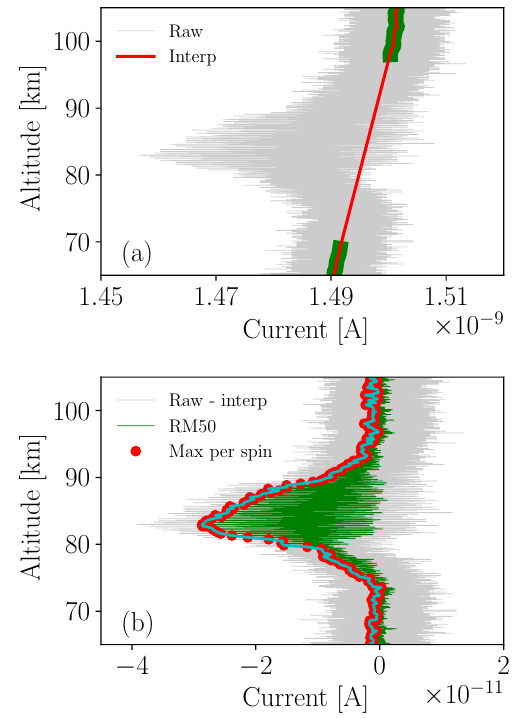
Figure 6. Conversion from raw current to charge density exemplary for PD 1. (a) Raw current (grey) and the interpolated trend (red). Green is the smoothed raw current. (b) Raw current subtracted by the interpolated trend from the upper panel. Running mean over 50 values (green) and the maximum current per spin (red dots).